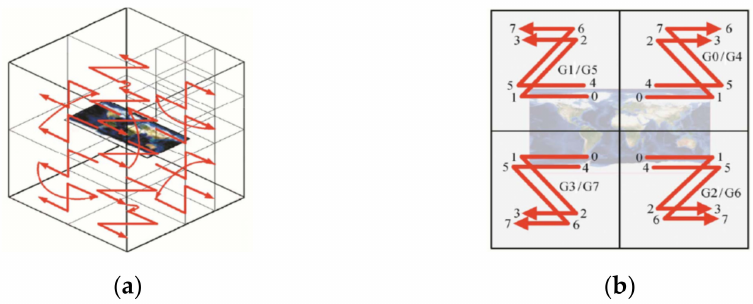
Figure 4. Schematic diagram of the coding sequence of GeoSOT 3D grid cells [26]. ( a ) Oblique view; ( b ) Top